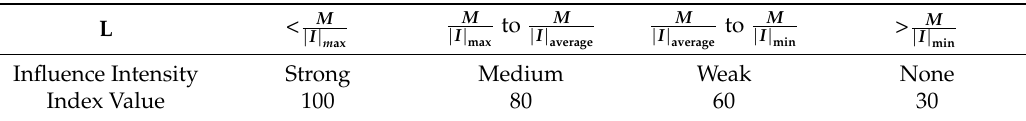
Table 8. Scoring criterion for the possible influence zone width of surface water under the condition of groundwater exploitation ( L